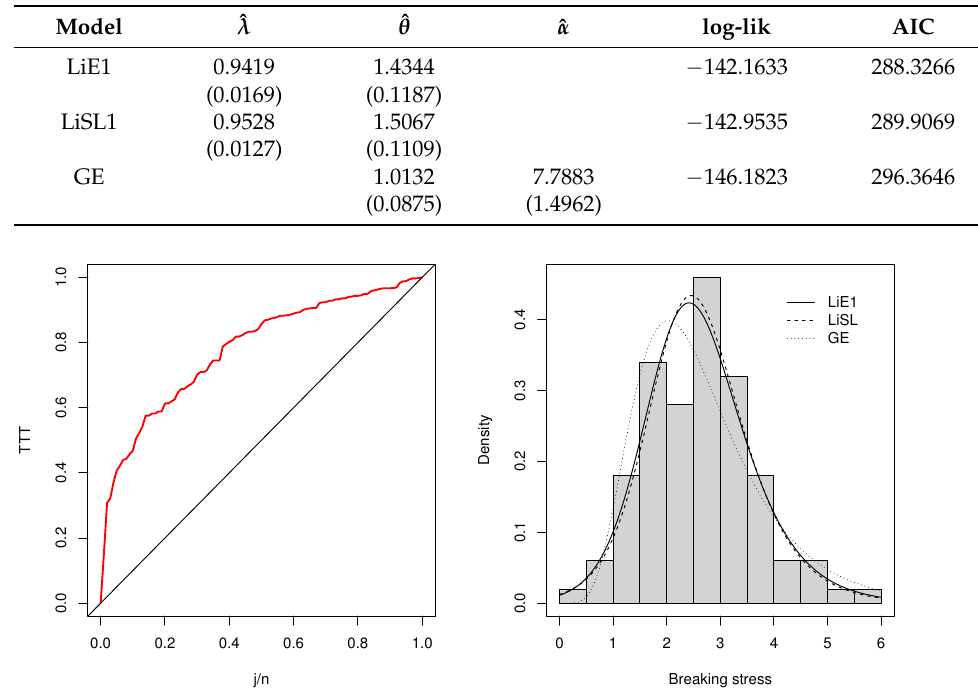
Figure 10. TTT plot of the data set (on the left ) and several fits for the Carbon data (on the right